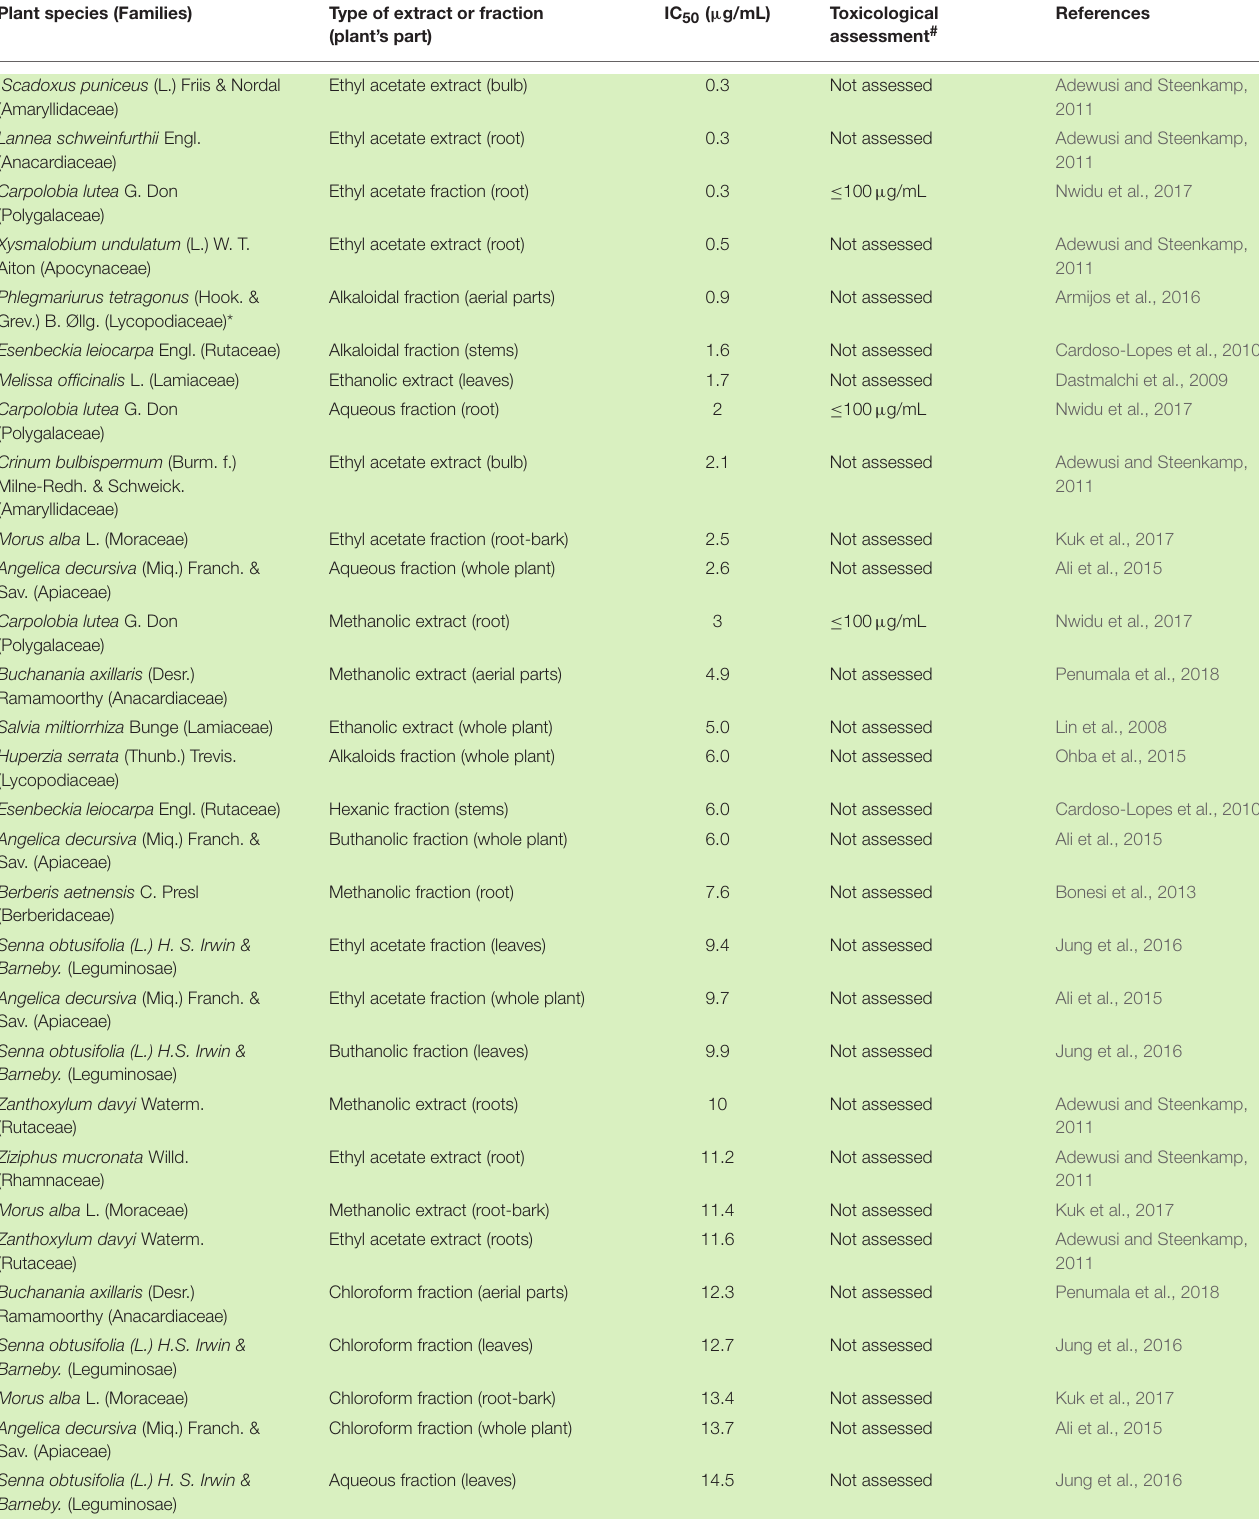
TABLE 1 | Plant extracts with in vitro anticholinesterase activity assessed by Ellman’s Method reported in Pubmed from 2007 to 2018 (1st semester). Plant species